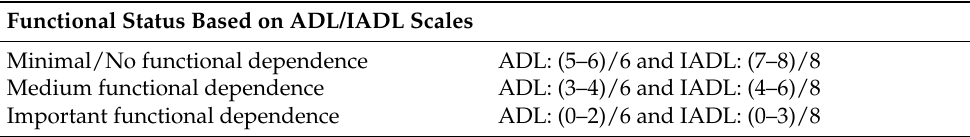
Table 1. Assessment criteria of functional status based on ADL/IADL score (maximum score on Katz Index ADL—6; maximum Lawton IADL